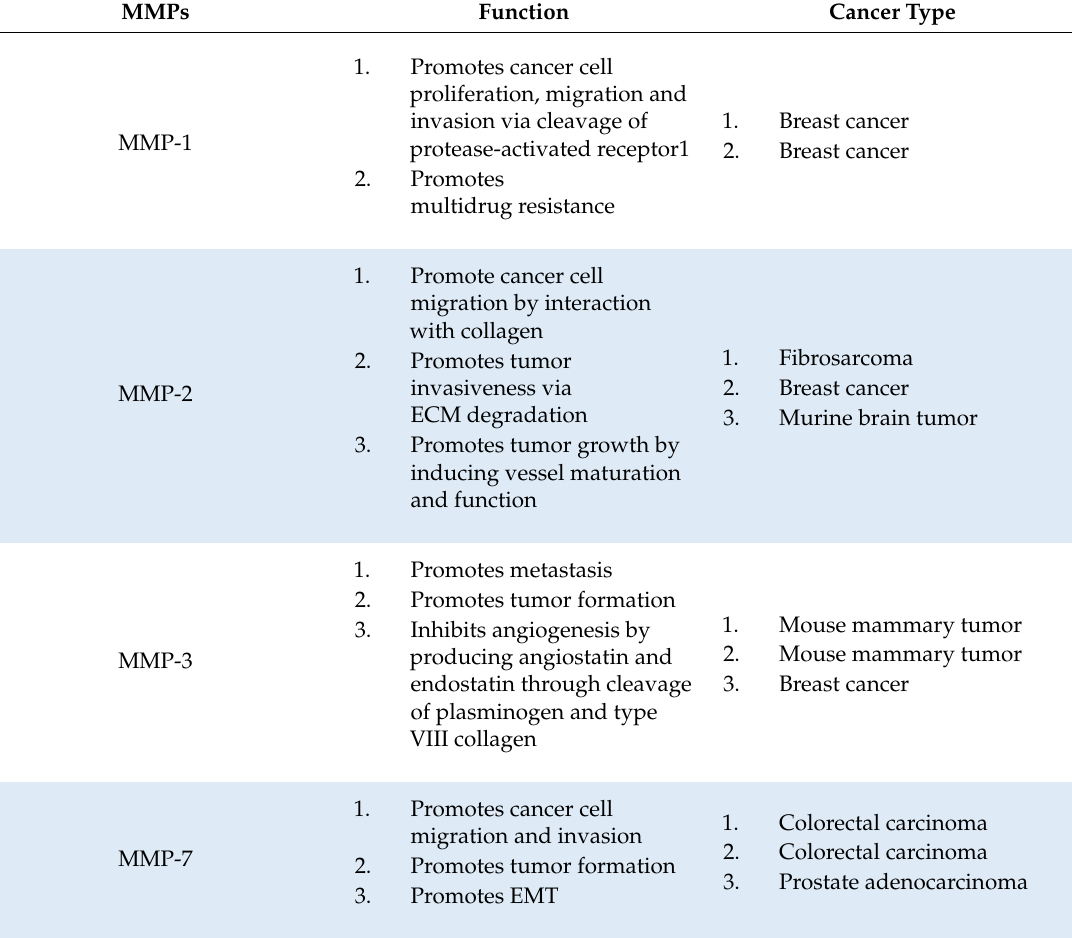
Table 1. Diverse matrix metalloproteases (MMPs) with either tumor-promoting or -suppressing functions in di ff erent types of